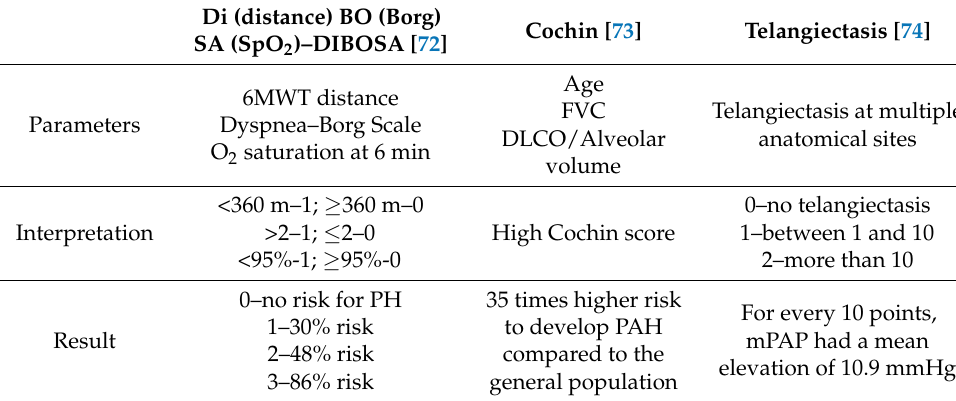
Table 6. Other PH screening methods. Modified after